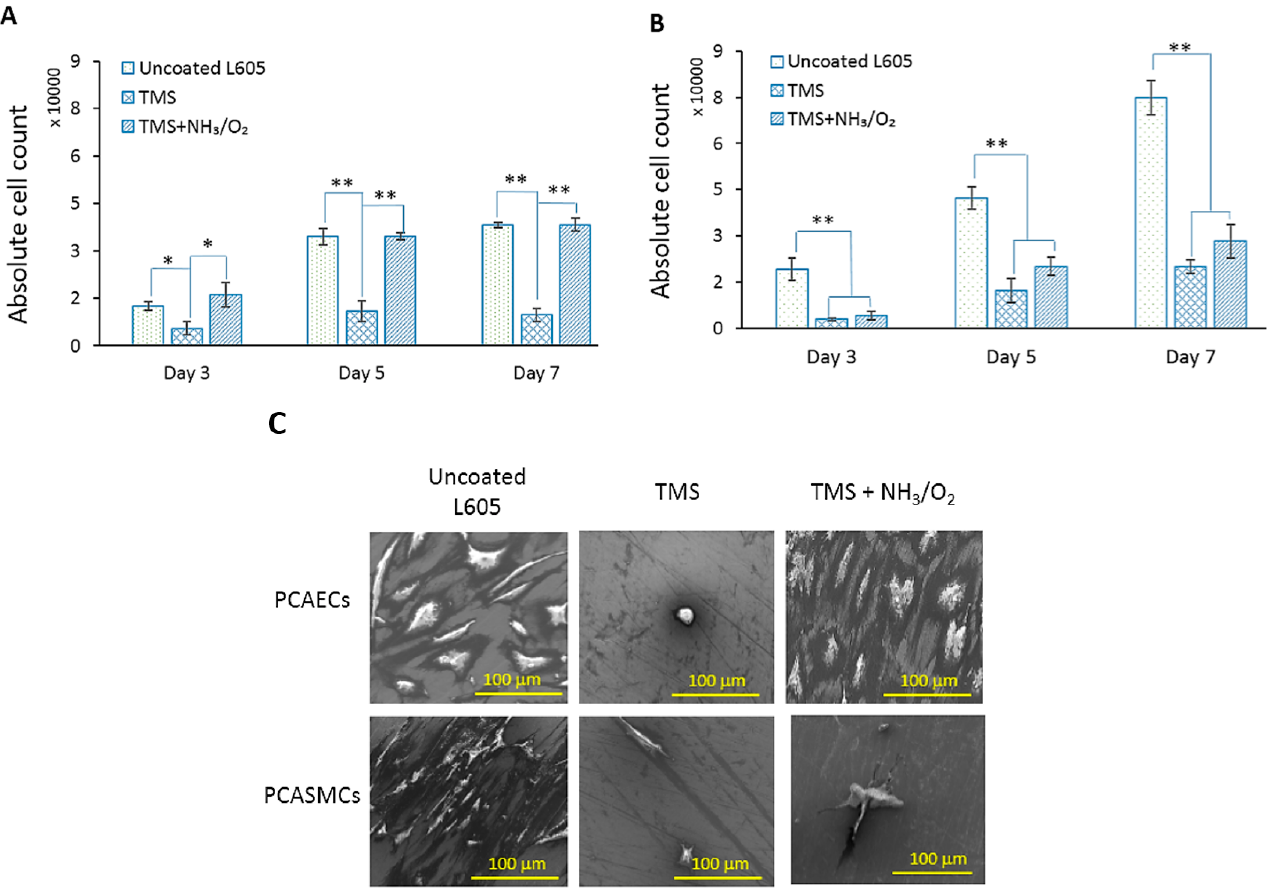
Figure 6. ( A ) Absolute PCAECs counts after 3-, 5-, and 7-day cell culture on uncoated, TMS, and TMS+NH 3 /O 2 plasma-nanocoated L605 coupons, performed with automated cell counting. Plotted values are means ± SD ( n = 6); * p < 0.05 and ** p < 0.005. ( B ) Absolute PCASMCs counts after 3-, 5-, and 7-day cell culture on uncoated, TMS, and TMS+NH 3 /O 2 plasma-nanocoated L605 coupons, performed with automated cell counting. Plotted values are means ± SD ( n = 6); * p < 0.05 and ** p < 0.005. ( C ) SEM images (1000×) for PCAEC and PCASMC cell morphology after 7 days incubation